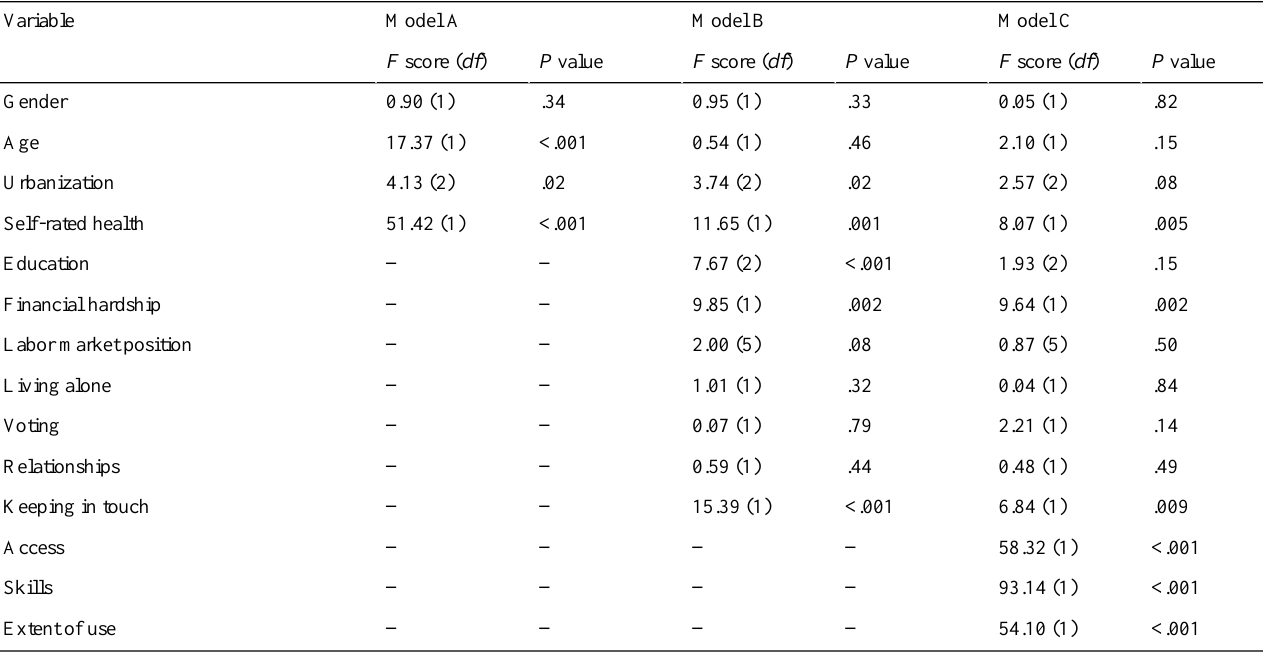
Table 3. The association of explanatory factors with perceived economic benefits (analysis of covariance, n=4495).